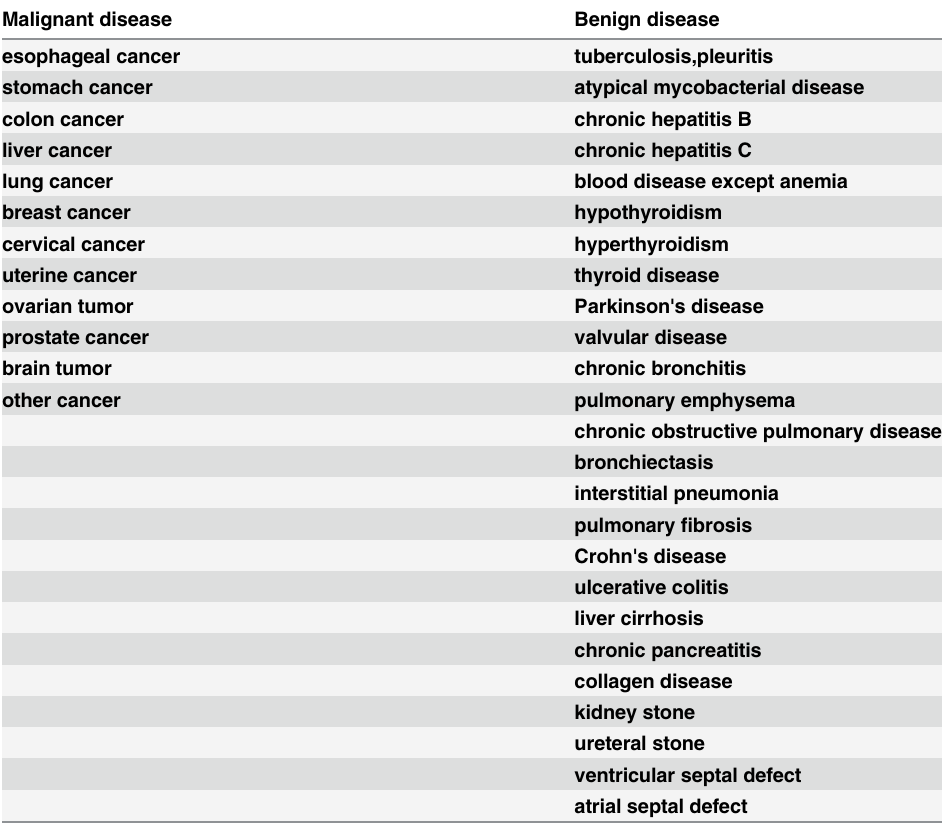
Table 1. List of excluded